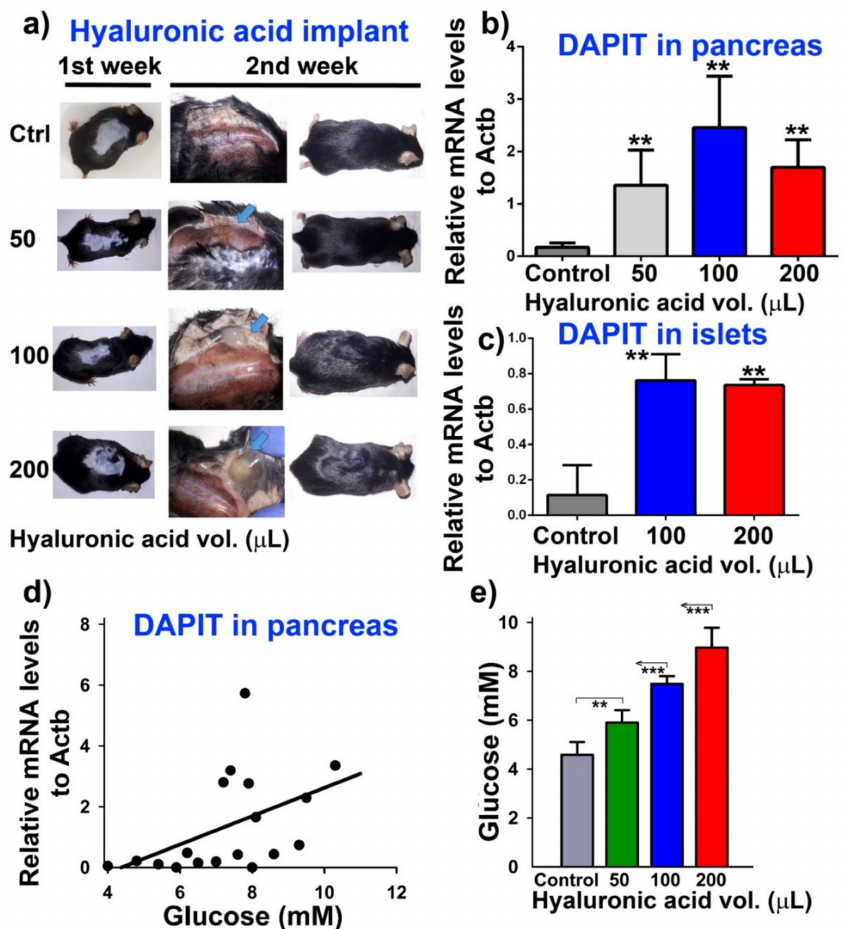
Figure 2. Upregulation of DAPIT in pancreas and pancreatic islets in mice. ( a ) typical experiment, ( b , d ) DAPIT mRNA in pancreas ( c ) in isolated pancreatic islets after two weeks of treatment with hyaluronic acid implants of the designated volumes. Data were mutually significantly di ff erent ( N = n = 5 mice per group): ** p < 0.05 (except 50 vs. 200 µ L) as well as data vs. control in ( c ); ( d ) dependence of DAPIT transcript in pancreas vs. glucose; resulting from fasting glucose levels in mice, calibrated relatively to volume of hyaluronic acid (see panel ( e ); *** p < 0.05). Spearman coe ffi cient for obtained fit is 0.56; p =